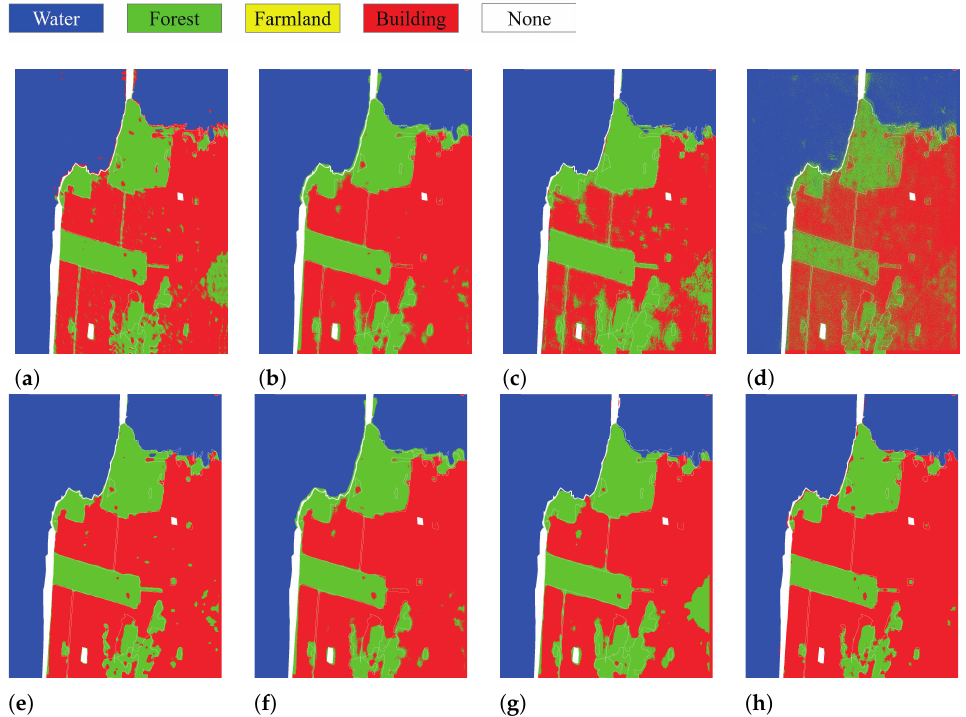
Figure 12. Classification results on Rs2-Sanf. ( a ) DenseNet. ( b ) RF. ( c ) KNN. ( d ) DT. ( e ) Co-training. ( f ) Tri-training. ( g ) S3VM. ( h )